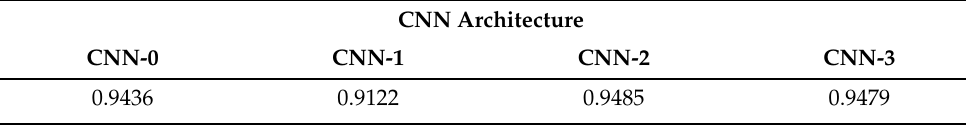
Table 2. Accuracy per CNN